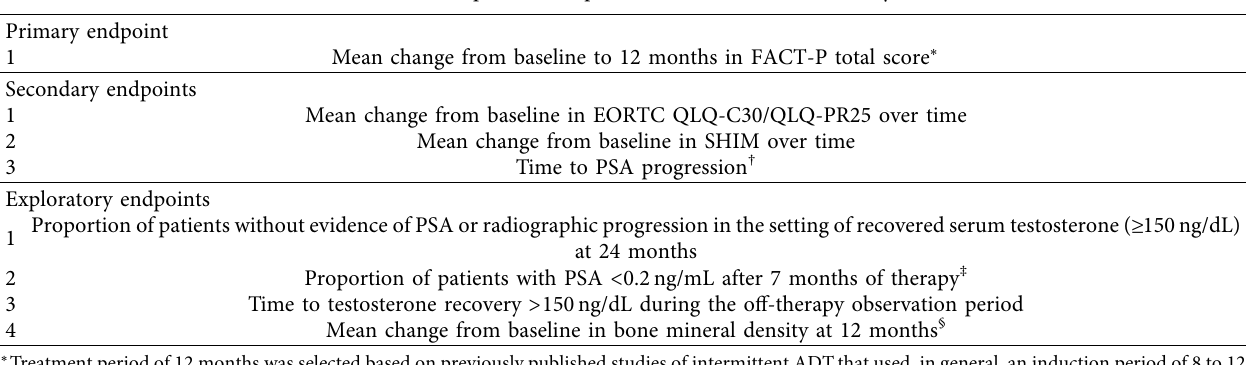
Table 2: Prespecified endpoints in the ARN-509-002